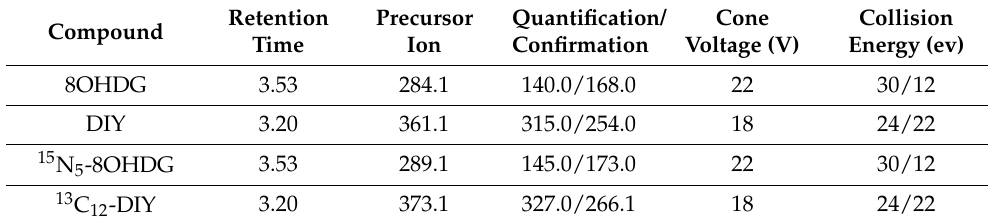
Table 1. UPLC–MS/MS